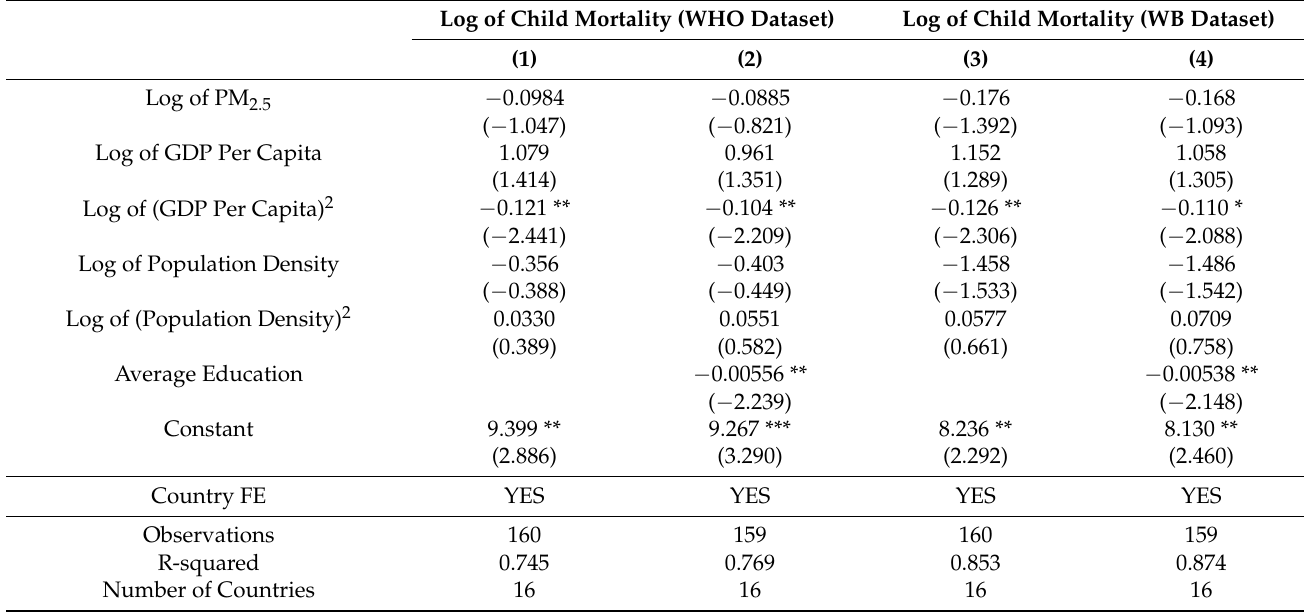
Table 1. Reduced-form effect of PM 2.5 on child mortality. Log of Child Mortality (WHO